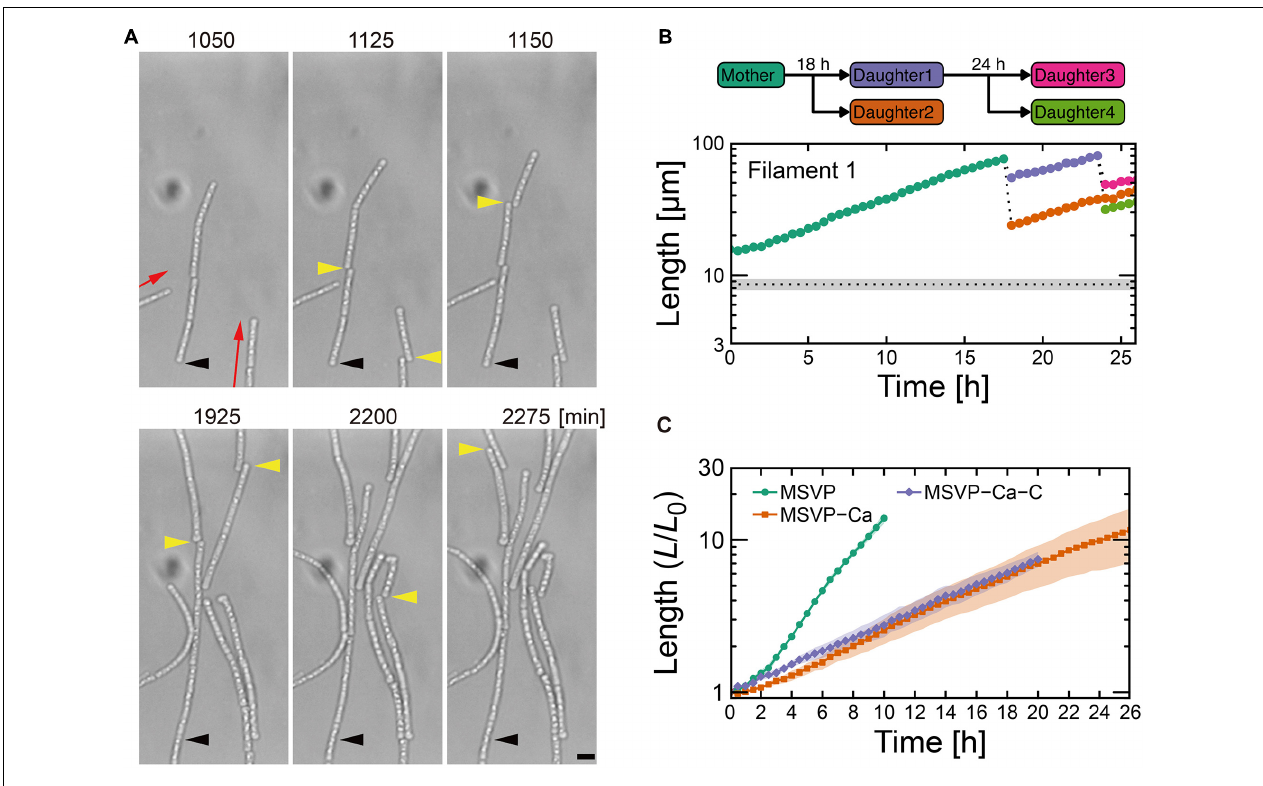
FIGURE 3 | Cell filament elongation in the fragmentation mode in MSVP-Ca. (A) Time-lapse sequence showing filamentous growth in MSVP-Ca after surface attachment ( t = 0). Black and yellow arrowheads indicate the same spatial positions and breaking points in each frame, respectively. Red arrows indicate the direction of elongation. Scale bars = 5 µ m. (B) The length increase measured as a function of time of a mother filament and the splintered filaments after fragmentation. Black dots line indicates the average length of cells immediately divided in MSVP. (also see Supplementary Figures 9A,B ). (C) Average length of all cells originated from three independent cell filaments measured as a function of time in MSVP, MSVP-Ca, and MSVP-Ca-C (purple). The filament length ( L ) is normalized by the initial length ( L 0 ) at t = 0. Filled regions represent the standard deviation (SD) from three